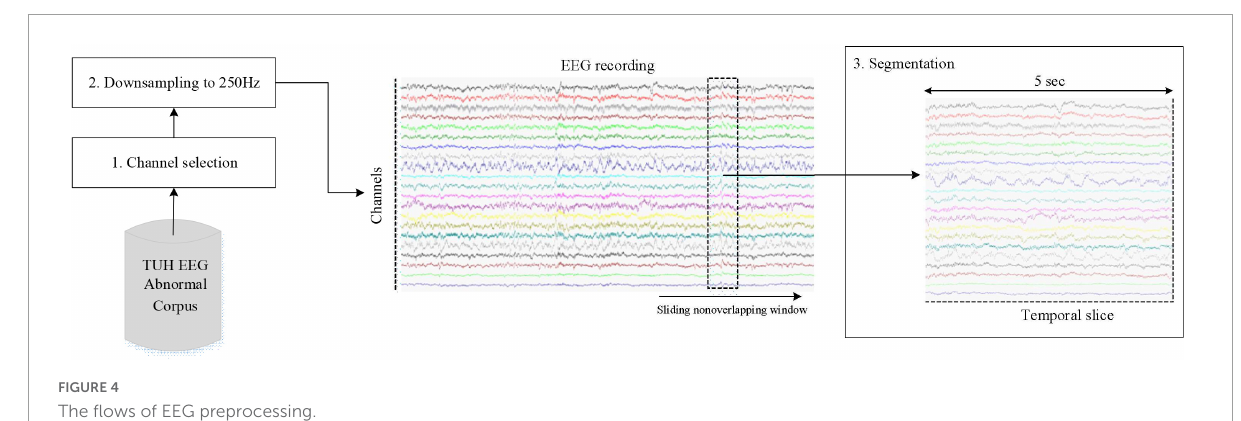
FIGURE3 Examples of EEG signals from C3, P3, and O1.